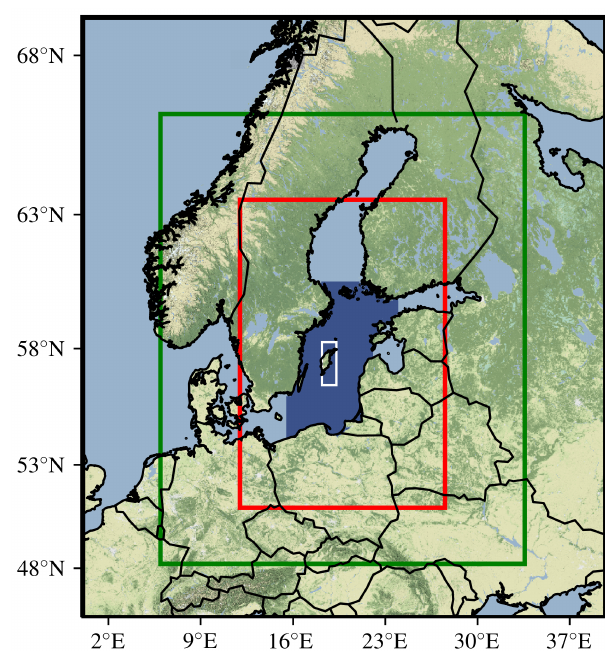
Figure 2. Nesting of different ICON domains with effective resolu- tions of 9 . 89km (black frame), 4 . 93km (green frame) and 2 . 47km (red frame) over the Baltic Sea region. The dark-blue area in the central Baltic Sea represents the model domain of GETM. The white rectangle frames the area shown in Fig.